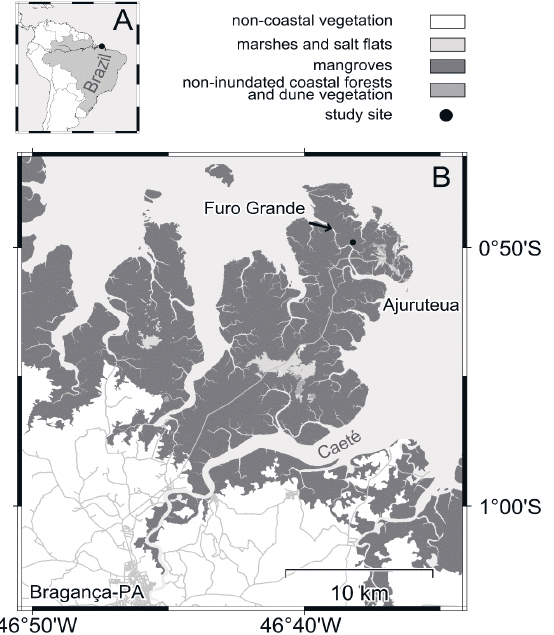
Figure 1. Study area (46°38 ′ W 0°50 ′ S) in Northern Brazil ( A ) near the city of Bragança on the Ajuruteua peninsula on the western bank of the Caeté estuary (area within the black dot). The study site is marked by a black dot and lies at the tidal channel Furo Grande ( B